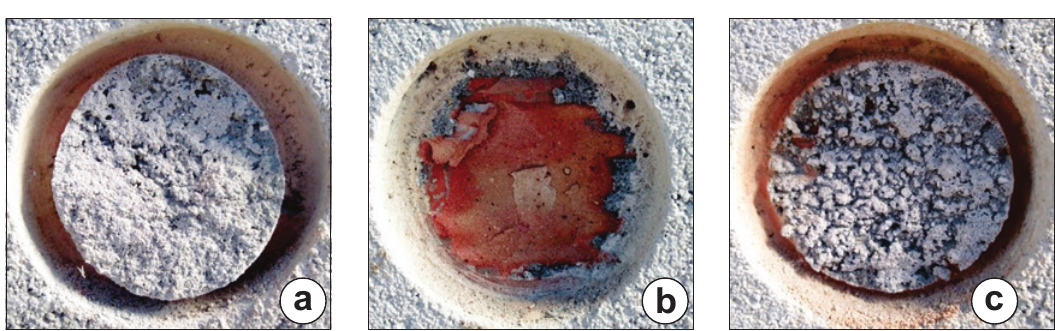
a b Figure 14 (a) Rupture in the mortar, (b) rupture in the substrate, (c) rupture in the interface mortar / base for mortar